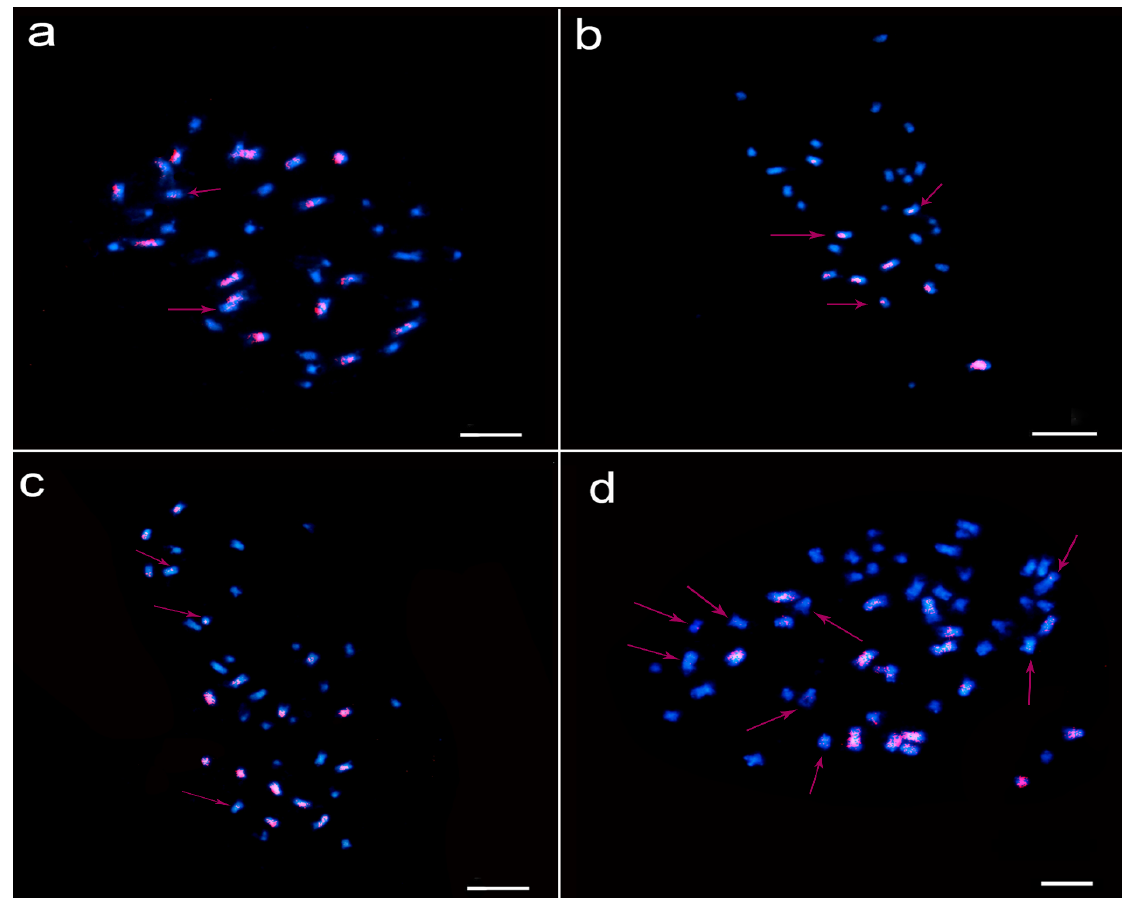
Figure 4. FISH diagram of partial F 1 and induced F 1 . ( a ) ZS11 FISH pictures; ( b ) T19-4 FISH pictures; ( c ) W58-9 FISH pictures; ( d ) W59-2 FISH pictures. The specific Brassica C genome sequence (DNA BNIH123L05) is indicated by the red signal, and A genome has no red signal. Some C chromosomes with weak red fluorescence are indicated by red arrows. Ruler = 20 μ m.